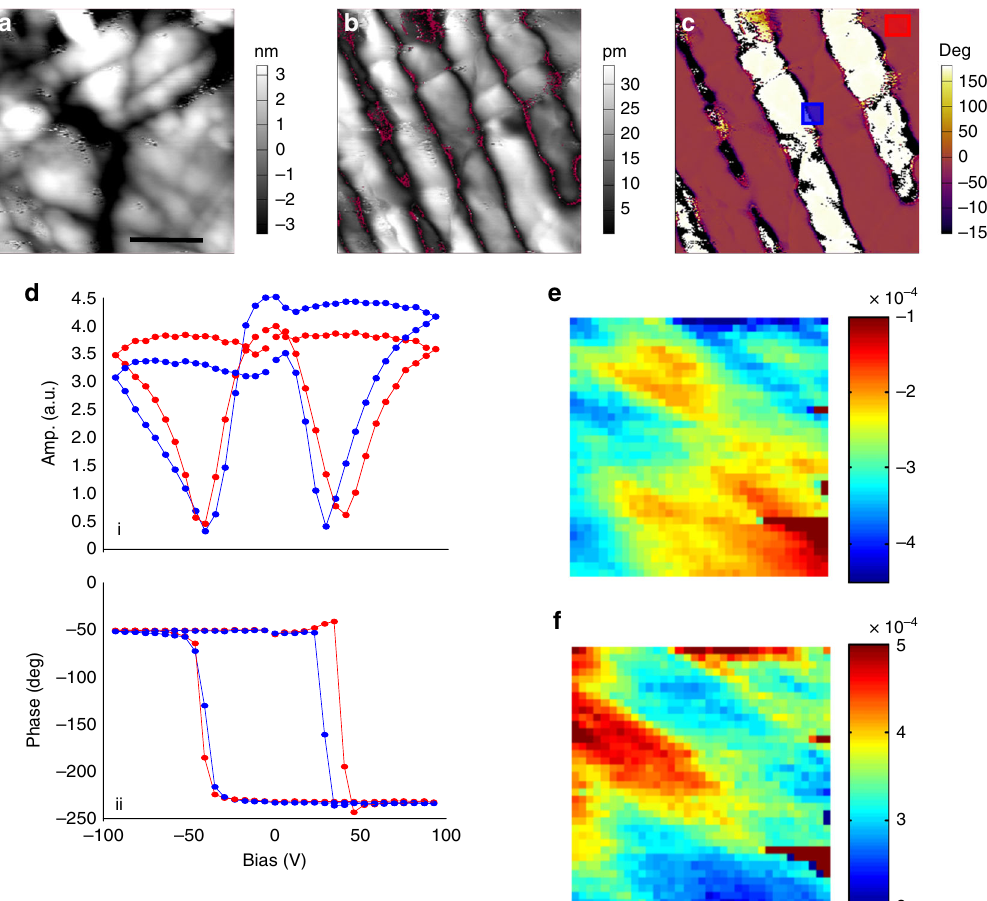
Fig. 5 PFM results on Mn 2 MnWO 6 . a Topography (scale bar 250 nm). b PFM DART amplitude and c phase. d average amplitude (i) and phase (ii) BE PFM switching spectroscopy loops determined from square regions indicated in the phase image in ( c ). Remnant e negative and f positive amplitudes determined from fi tting 35 × 35 grid measurement. Scale bar is the same for Fig. 5a –